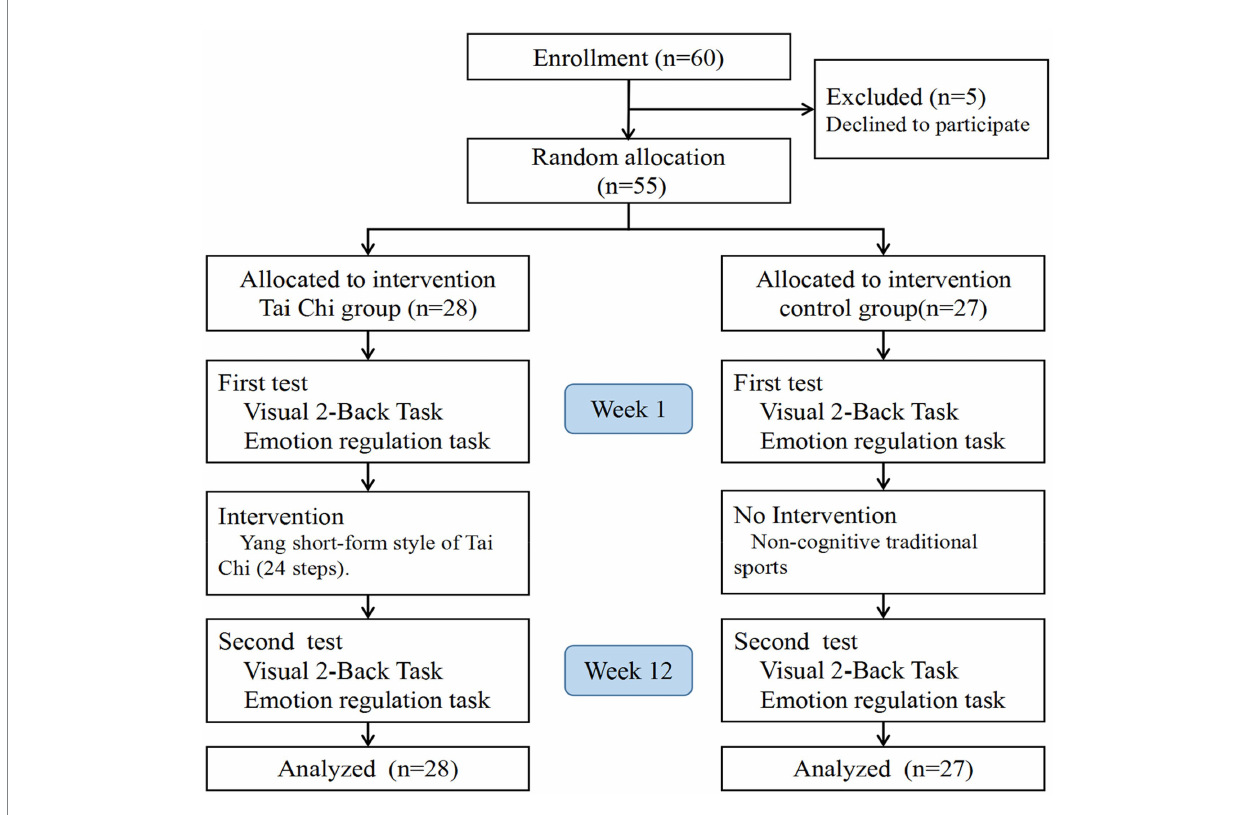
FIGURE 1 Flowchart of enrollment, baseline, and